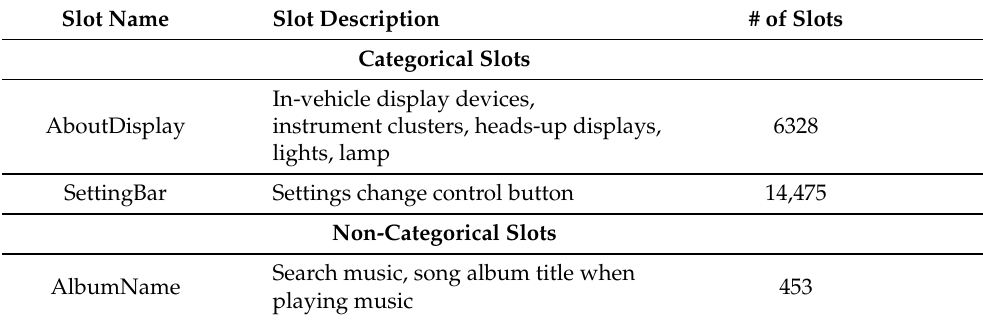
Table 3. Slot statistics and descriptions. The number of slots is also indicated that exist in the dataset. Slot